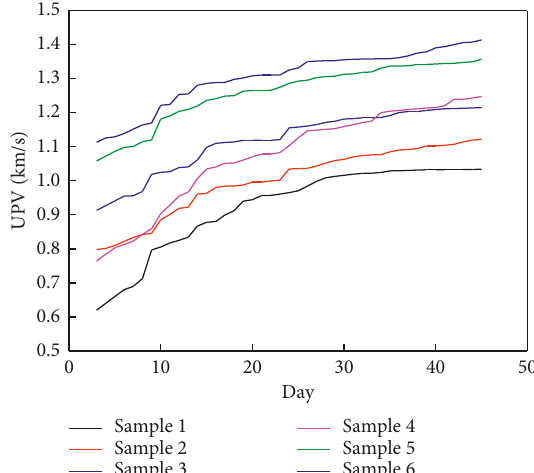
Figure 4: UPV versus curing period for FMLS.